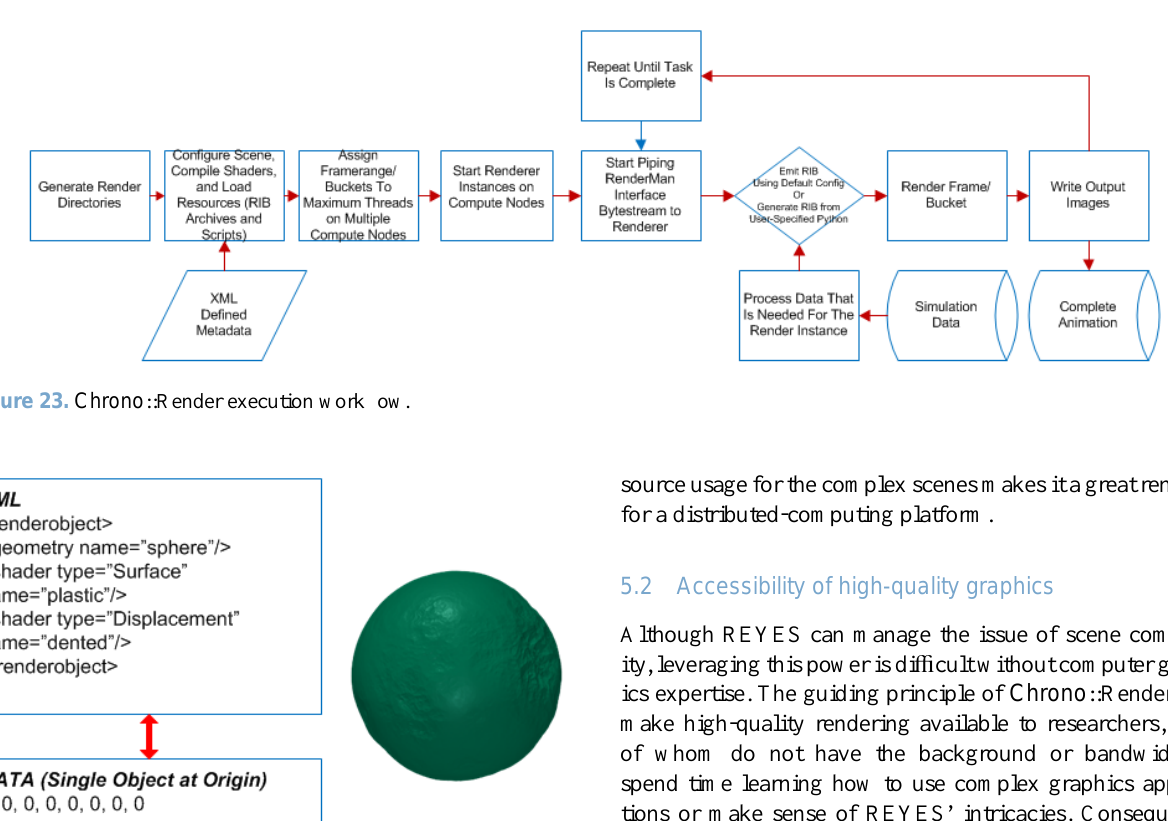
Figure 24 : Simple XML for a sphere with a Surface and Displace- ment shader. Although simple, the render is visually rich. This description is often enough to visualize most generic data, but it can- not handle all arbitrary visualizations, so in order to maintain generality we make use of Python scripts and wrappers to en- able simplified procedural RenderMan Interface Bytestream generation. Any XML element can be scripted such that at runtime, the script output will be piped into the same ren- dering context.